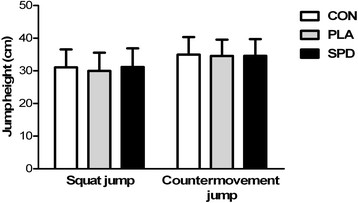
Mean (±SD) jump height for the squat (SJ) and countermovement (CMJ) jumps in the 3 conditions (CON, PLA and SPD). For SJ and CMJ, inter-group analysis was carried out using the Kruskal-Wallis one-way analysis; no statistical differences were found.